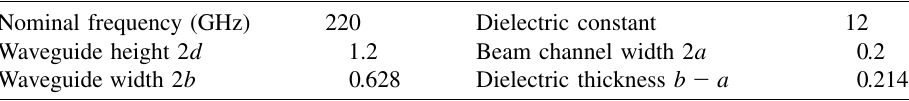
TABLE I. TWT parameters and structure dimensions (mm) used in simulations.